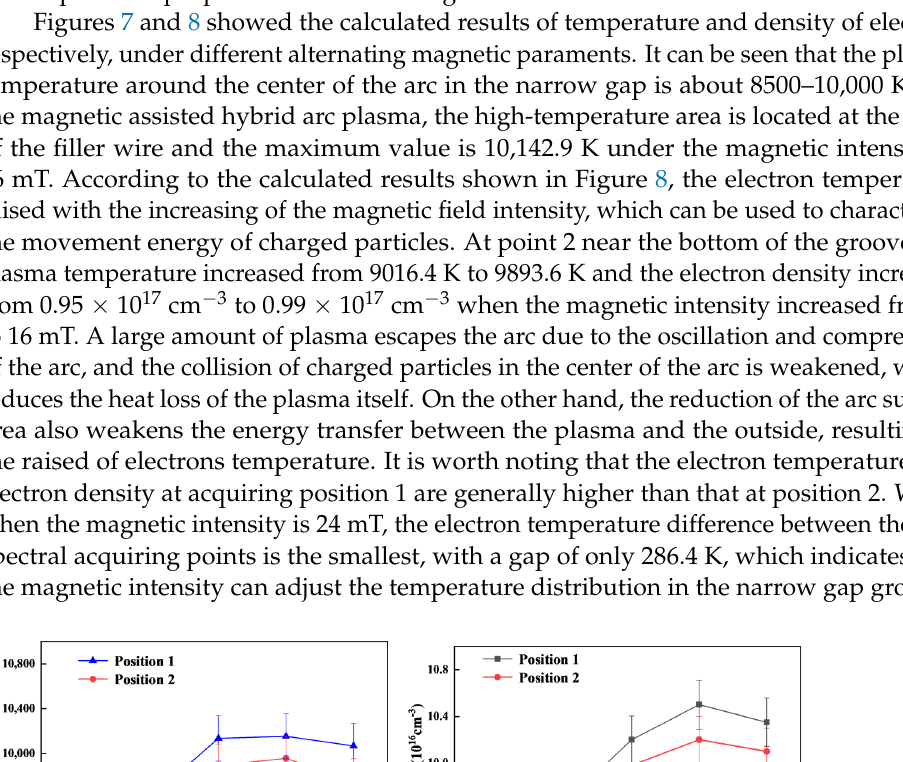
Figure 6. Spectrum of arc plasma in laser–MIG hybrid welding with magnetic field: ( a ) plasma spectrum and ( b ) spectral acquisition positions.